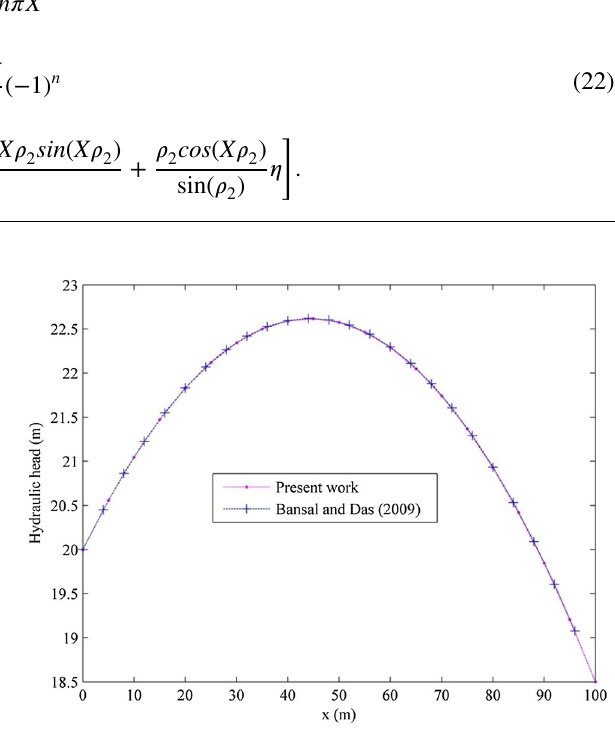
Fig. 3 Comparing the presented exact model with the analytical solu- tion of Bansal and